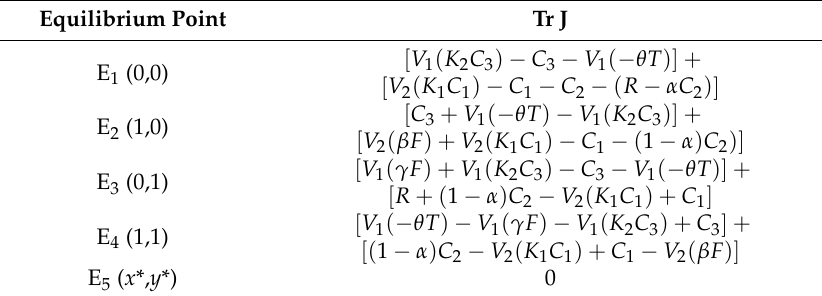
Table 3. The formula of the trace for each equilibrium